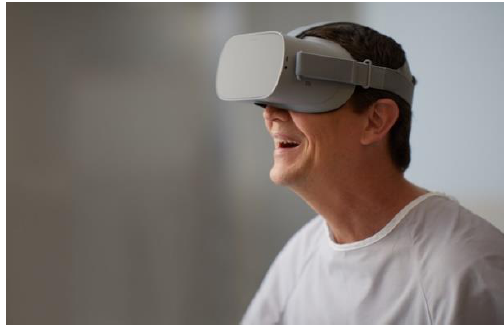
Figure 1. Example of a virtual reality (VR) headset provided by AppliedVR.